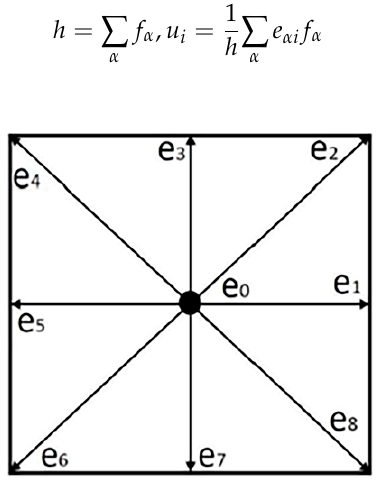
Figure 3. D2Q9 lattice pattern (D2 represent two-dimensional and Q9 represent nine velocity directions in each particle).